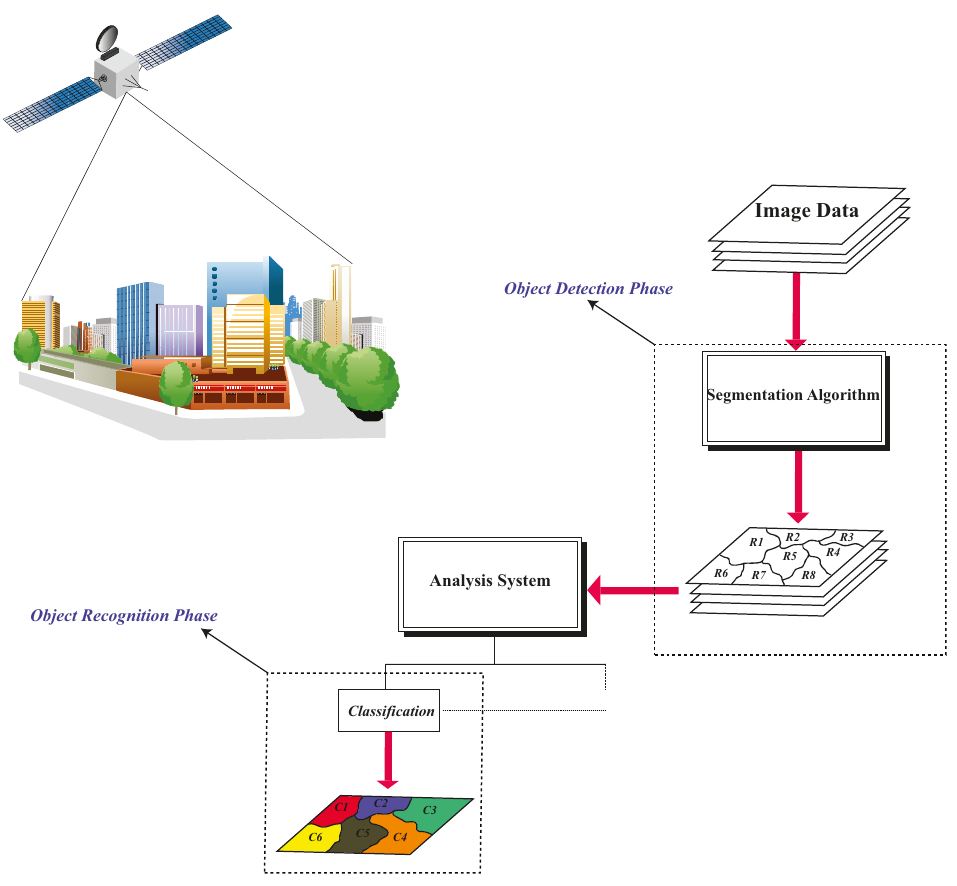
Figure 2. Workflow of GEOBIA framework in remote sensing.